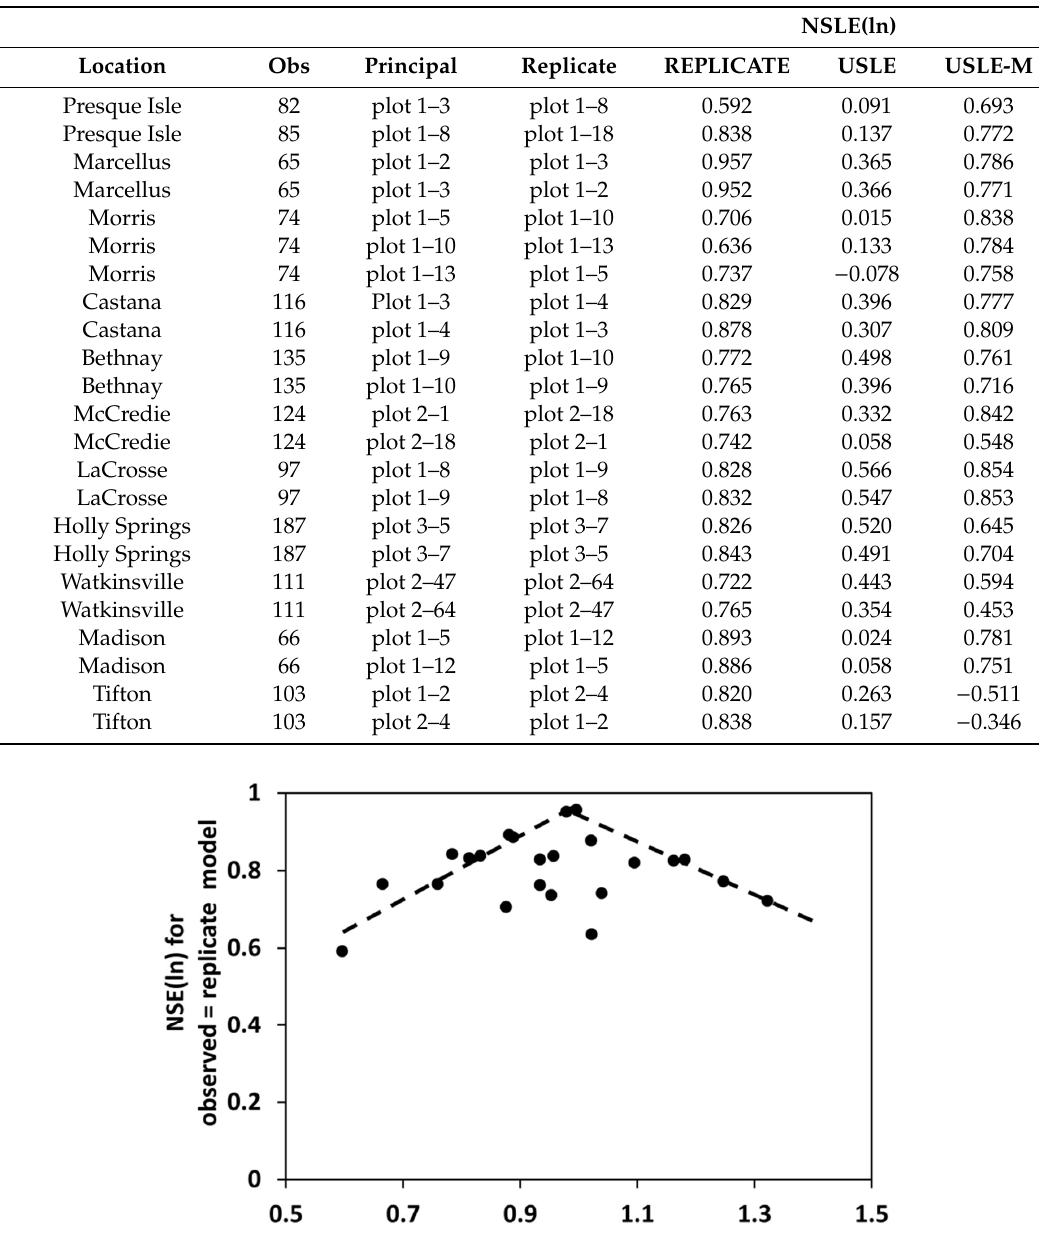
Table 6. NSE(ln) values when USLE, USLE-M, and replicate models were applied to bare fallow plots in the USLE database (source: Kinnell [63]).